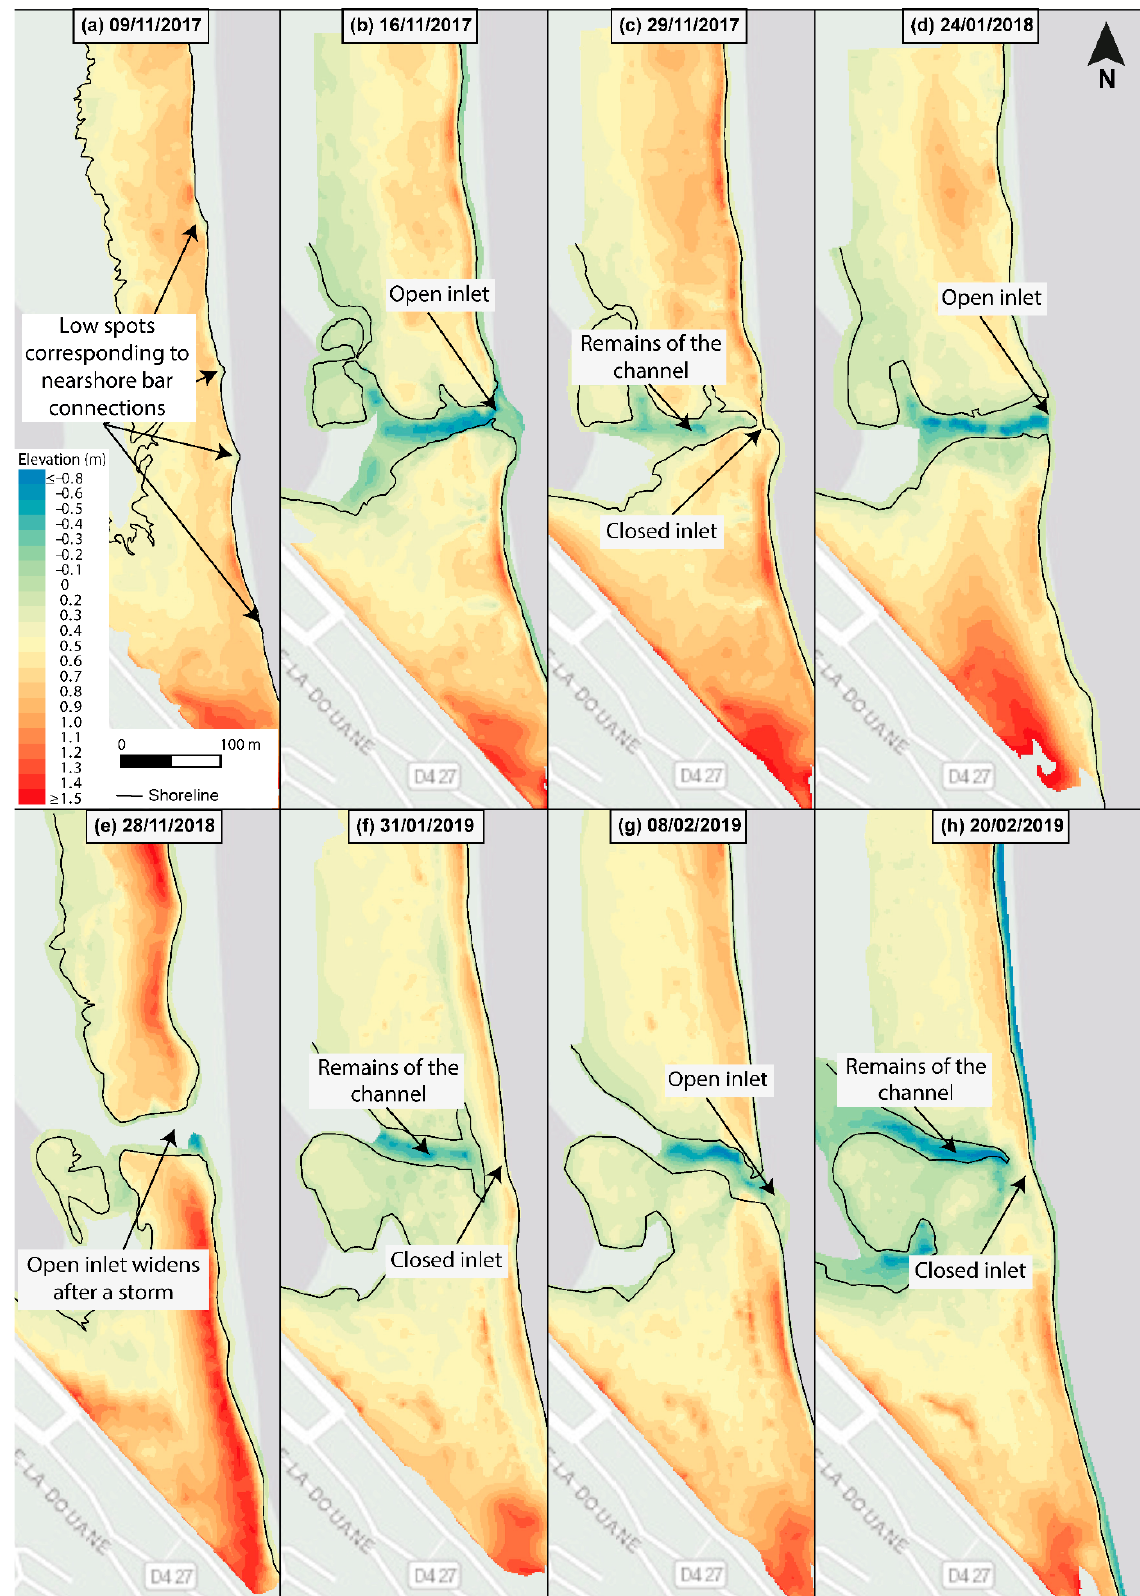
Figure 8. Inlet dynamics over the winter periods of 2017/2018 and 2018/2019.